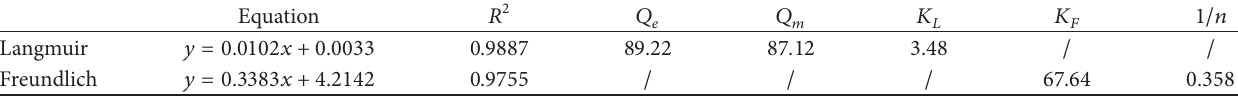
Table 2: Parameter values of the isotherms adsorption of methylene blue onto activated carbon from cola nut shells. Equation